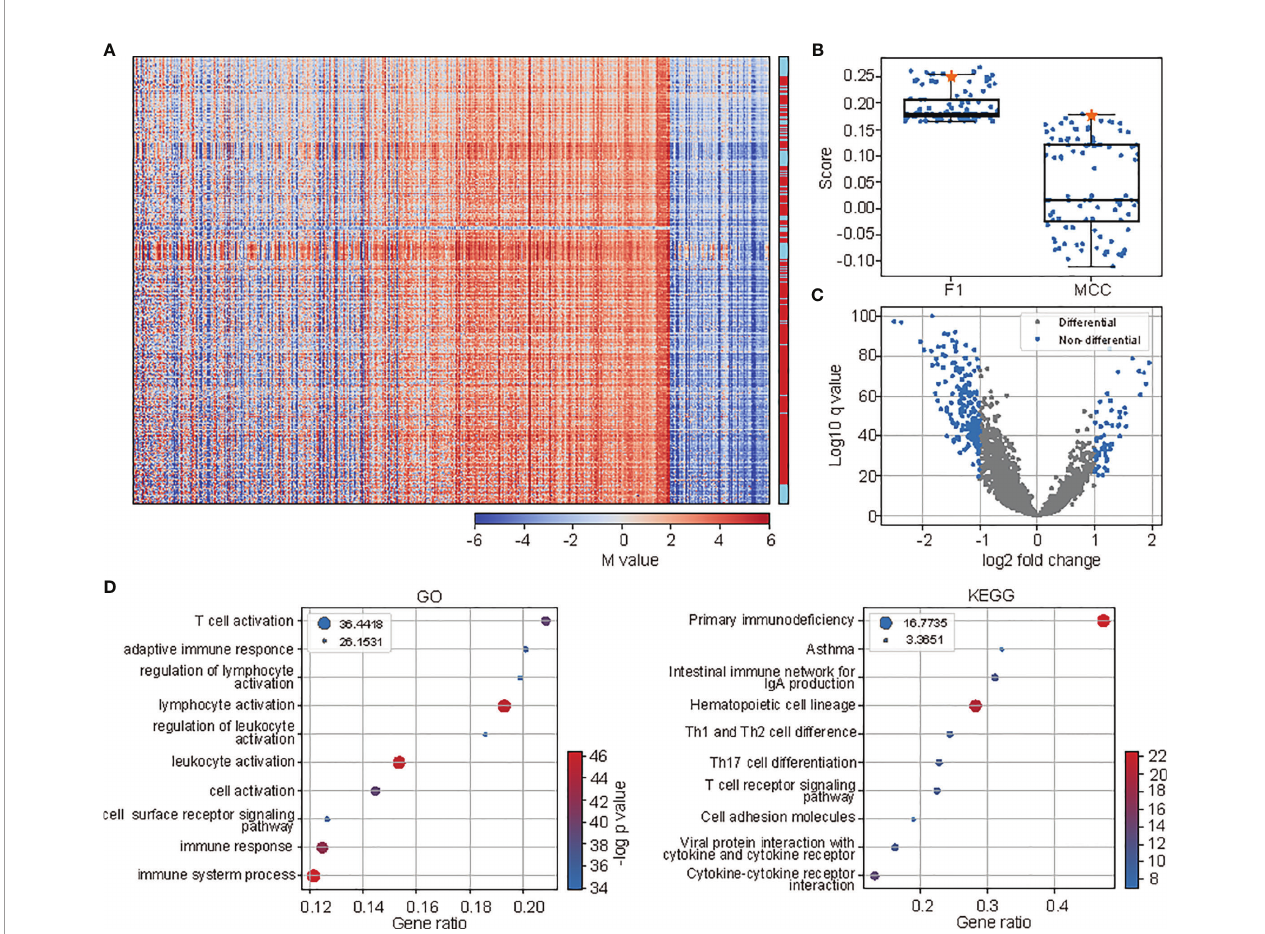
FIGURE 2 | The methylation pro fi les of selected probes indicated the differences between cases with and without responsiveness to ICI treatment. (A) The methylation pro fi les (M-value) of selected probes of all samples. The samples (rows) and probes (columns) were all rearranged according to hierarchical clustering. Cases with responsiveness to ICI were marked as red at the right panel. (B) The comparison of separation between cases with and without responsiveness to ICI based on hierarchical clustering of methylation pro fi les of selected probes and the randomly selected probes as controls. (C) The volcano plot showing the results of differential methylation analysis of selected probes. (D) The functional enrichment analysis (left: GO, right: KEGG) of genes where the selected probes were located. The top 10 terms were shown. The size of circles represents the logged FDR values, while colors represent the